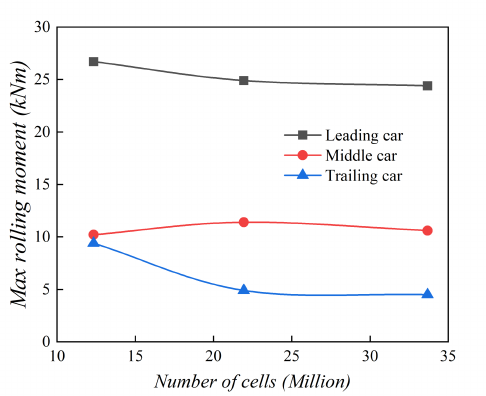
Figure 5. Maximum rolling moment of three cars predicted by different meshes (in V t = 300 km/h; V w = 20